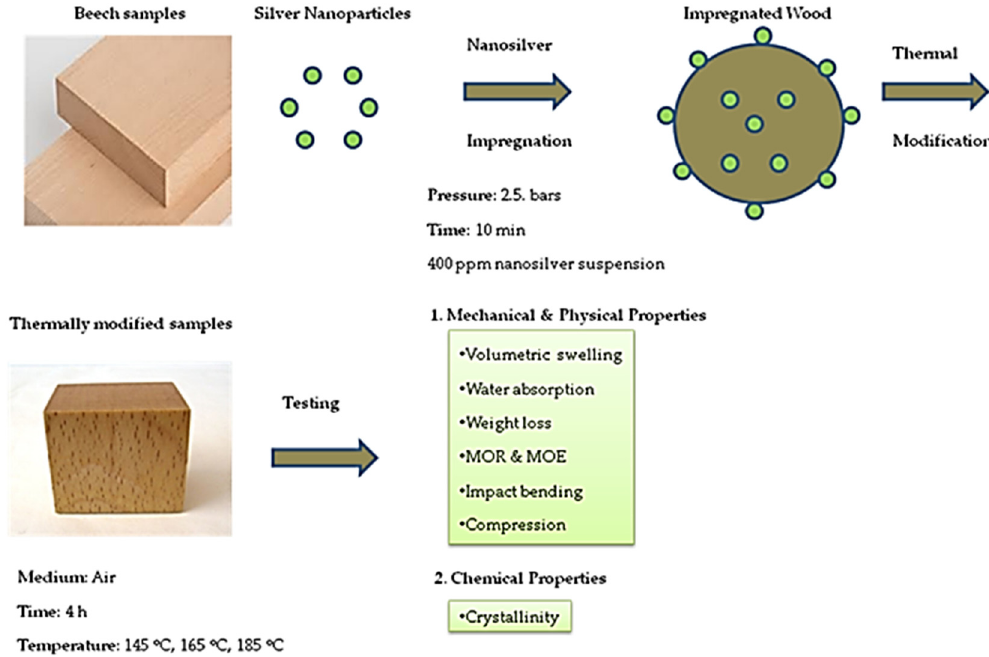
Figure 18: Technological process of impregnating nanometer silver suspension [ 166 ]